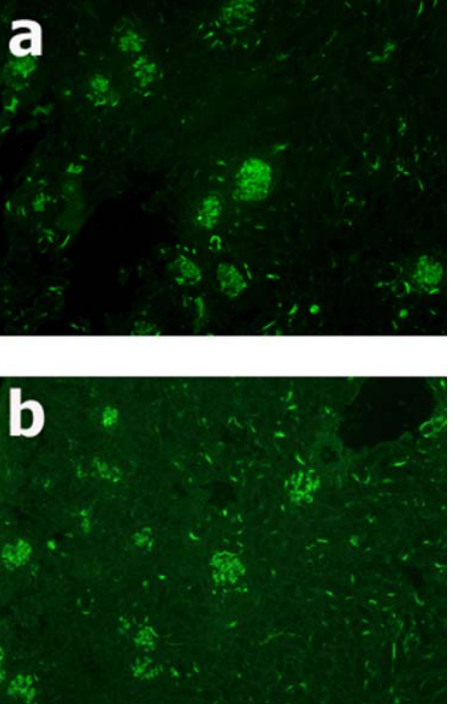
Figure 4. Immunohistochemical localization of C3 in WT background chimeric mice treated with HSA/LPS. 100 6 views of kidney sections from WT IR /WT ( a ) and WT IR /C3KO ( b ) chimeras stained with FITC-conjugated goat anti-mouse C3c.